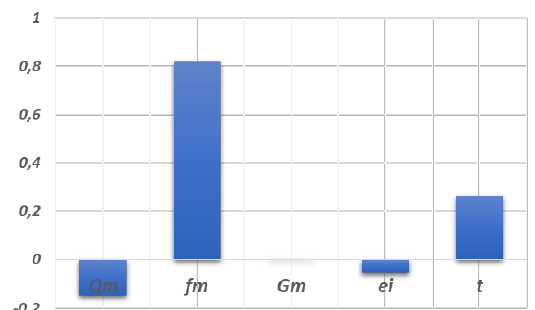
Figure 7: Chart of sensitivity of the reliability index to random vari-